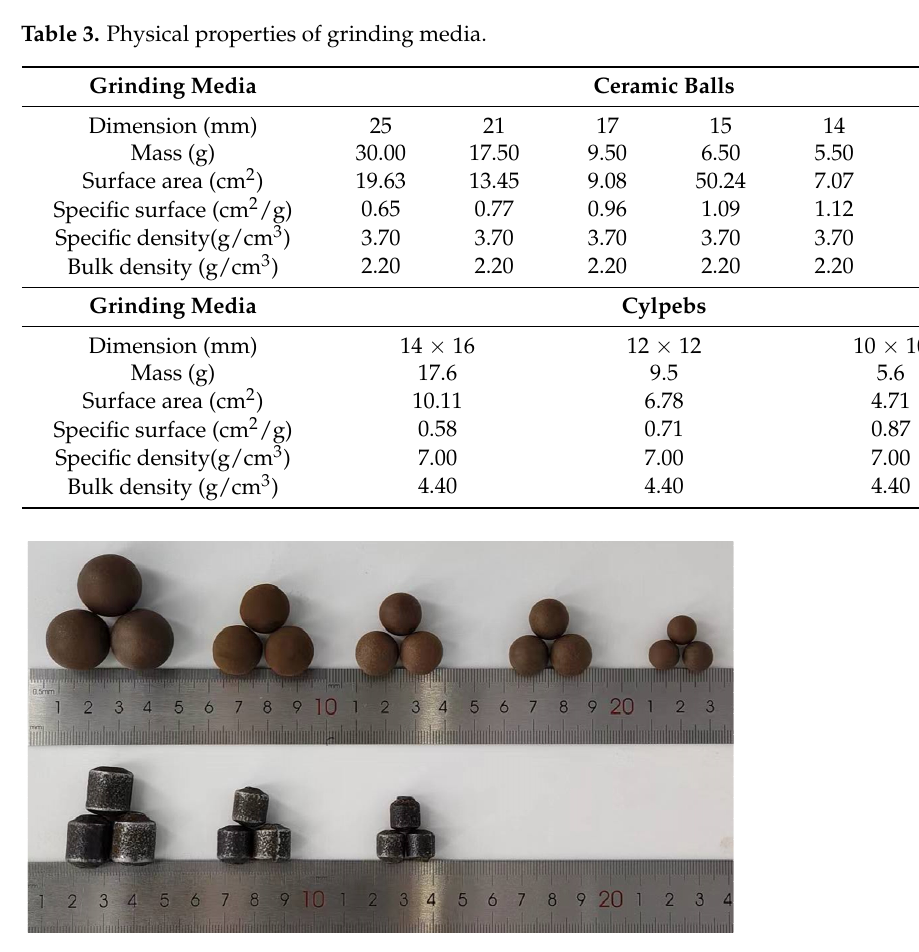
Figure 2. Photographs of the grinding media. Table 2. Composition properties of grinding media.